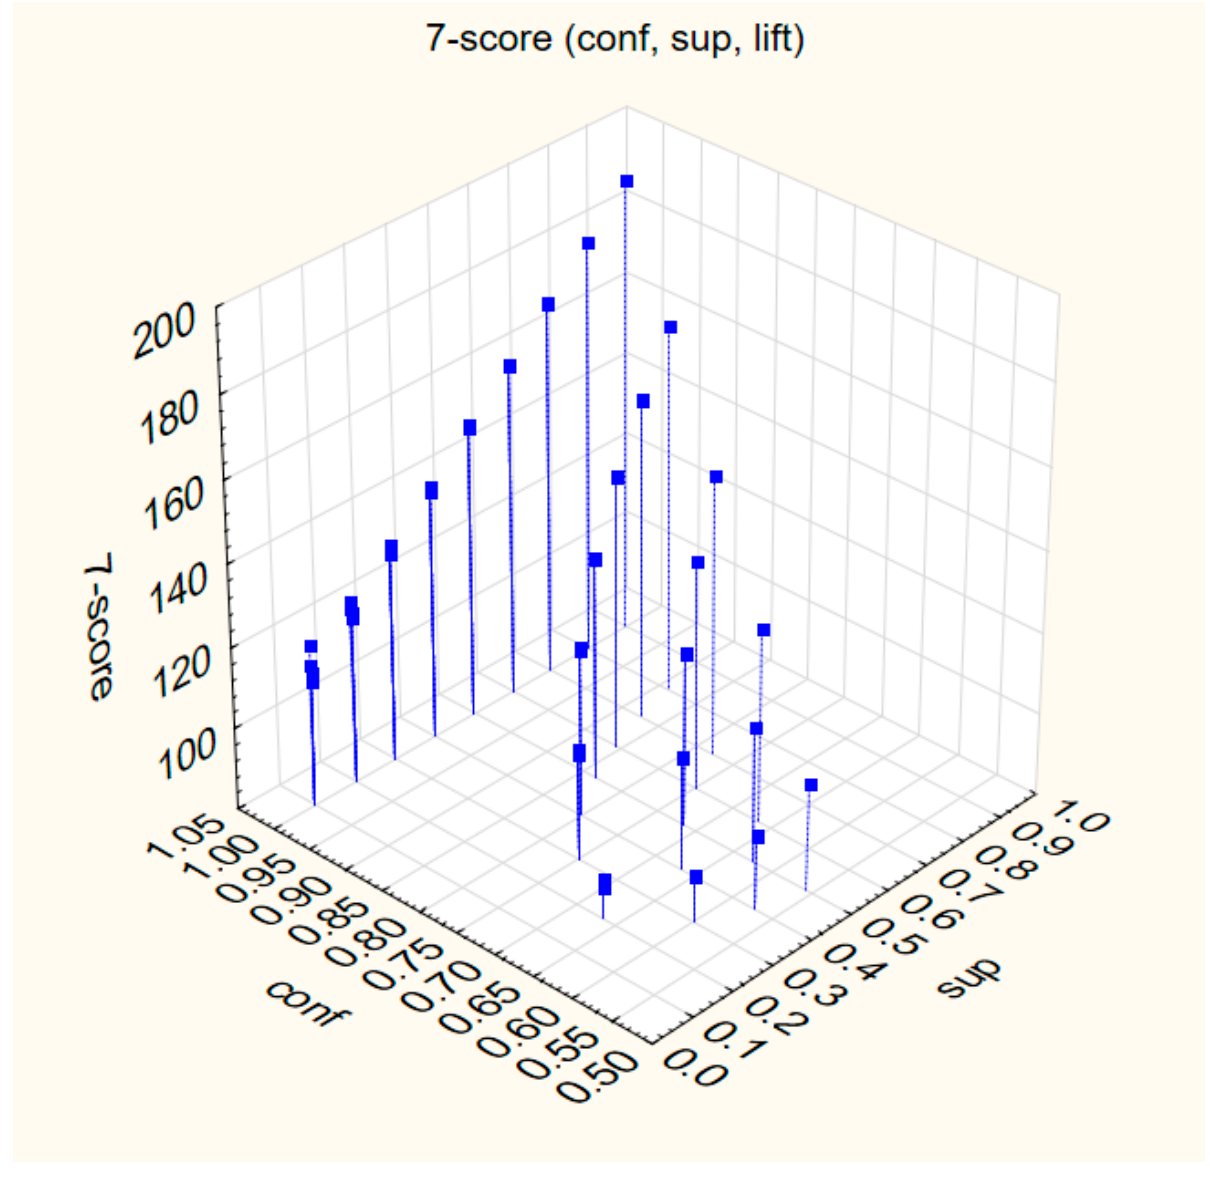
Figure 6. 7-Score values are presented for every combination of important rules presented in Table A1.